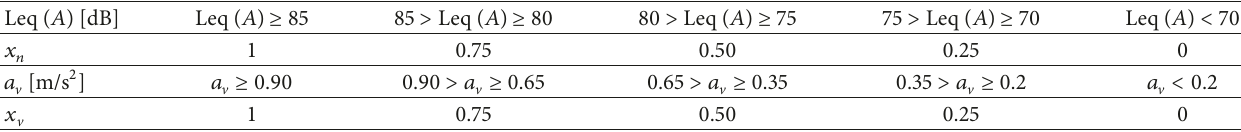
Table 4: Identification of parameters 𝑥 𝑛 and 𝑥 V .